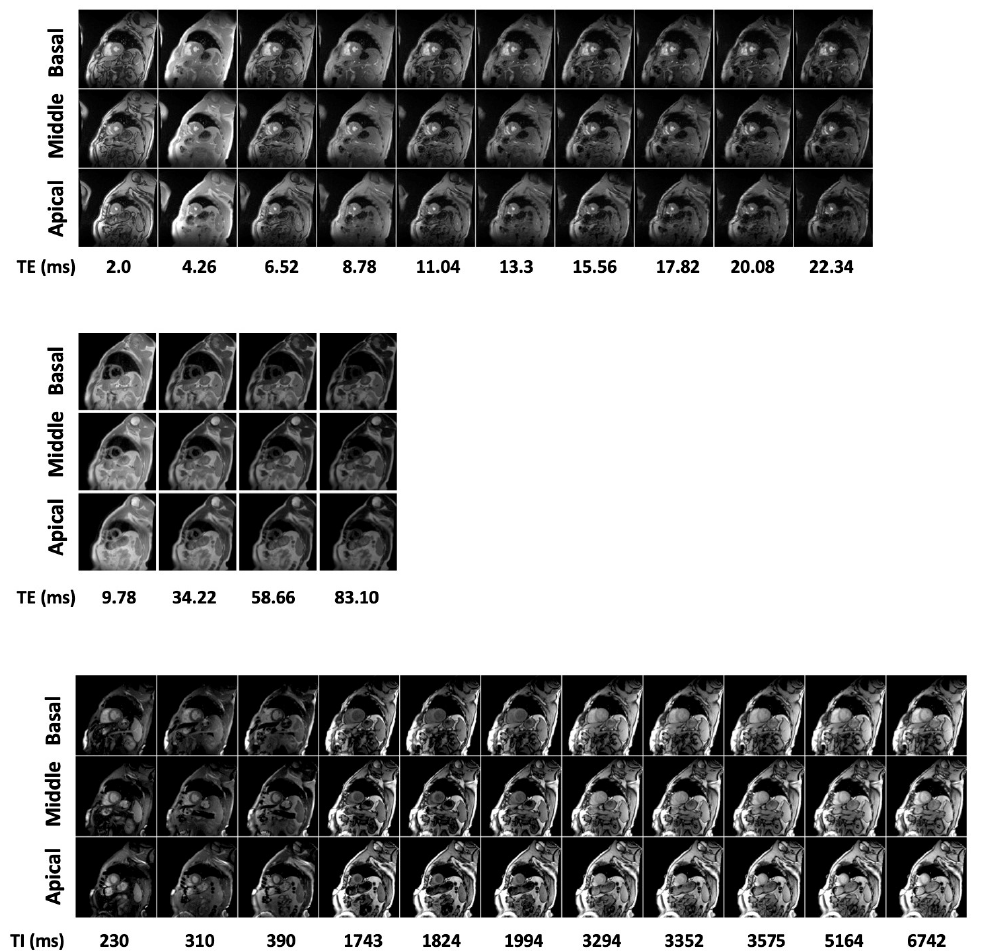
Figure 1. Examples of T2* (upper panel), T2 (middle panel) and T1 (lower panel) CMR image sequences.